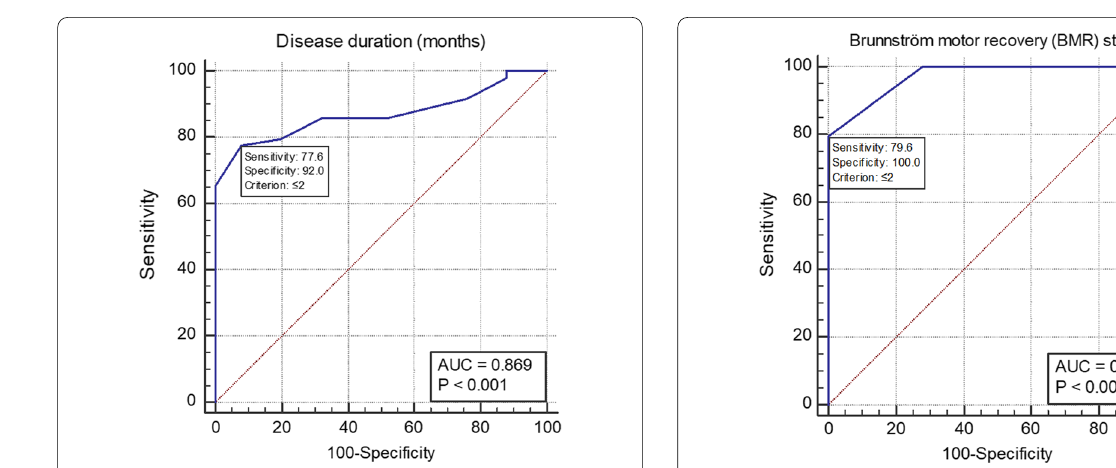
Fig. 8 The Brunnström motor recovery (BMR)